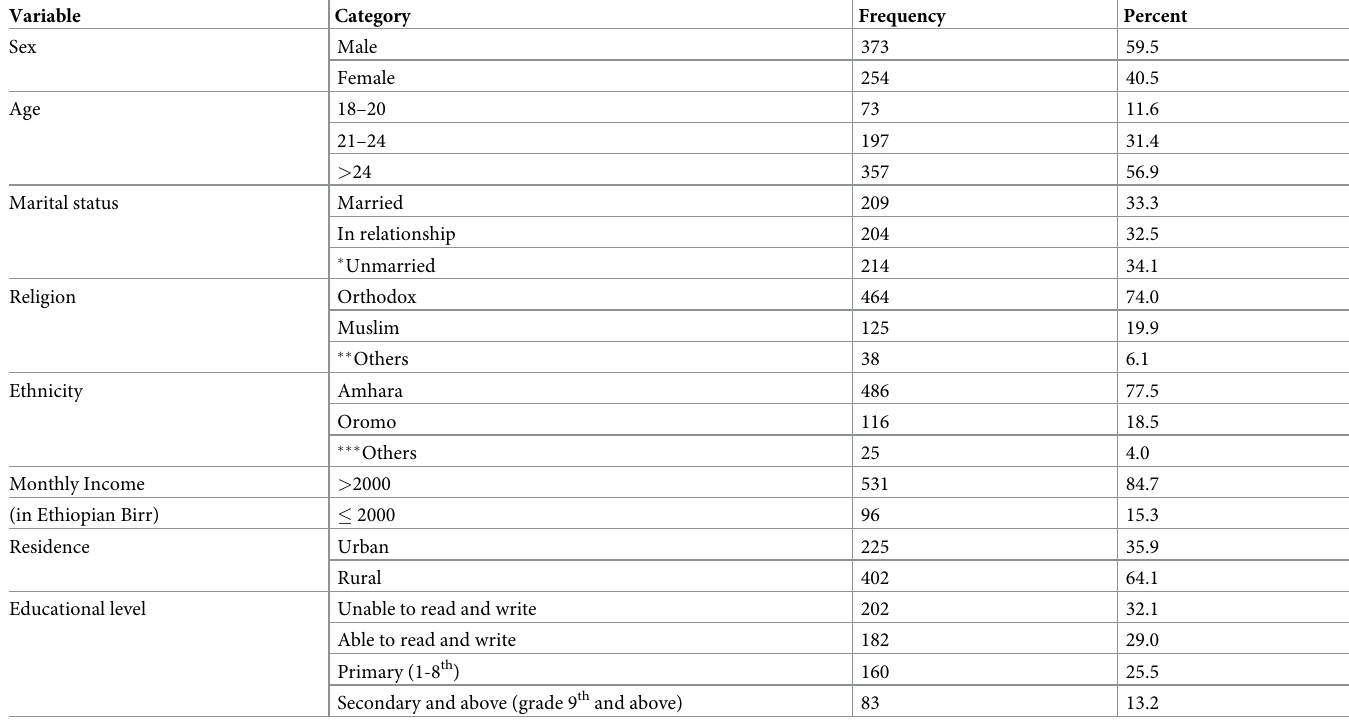
Table 1. Socio-demographic characteristics of big construction site daily